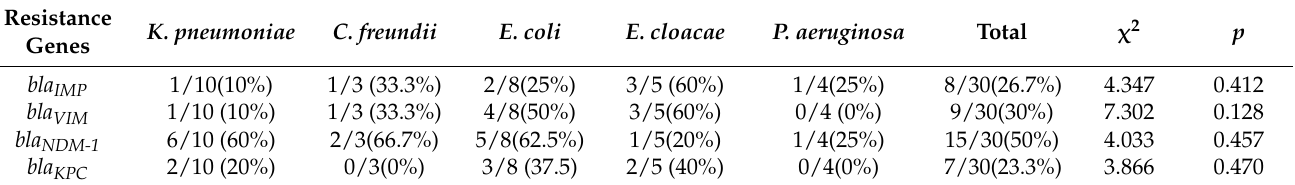
Table 4. Frequency of carbapenemase-encoding genes in different